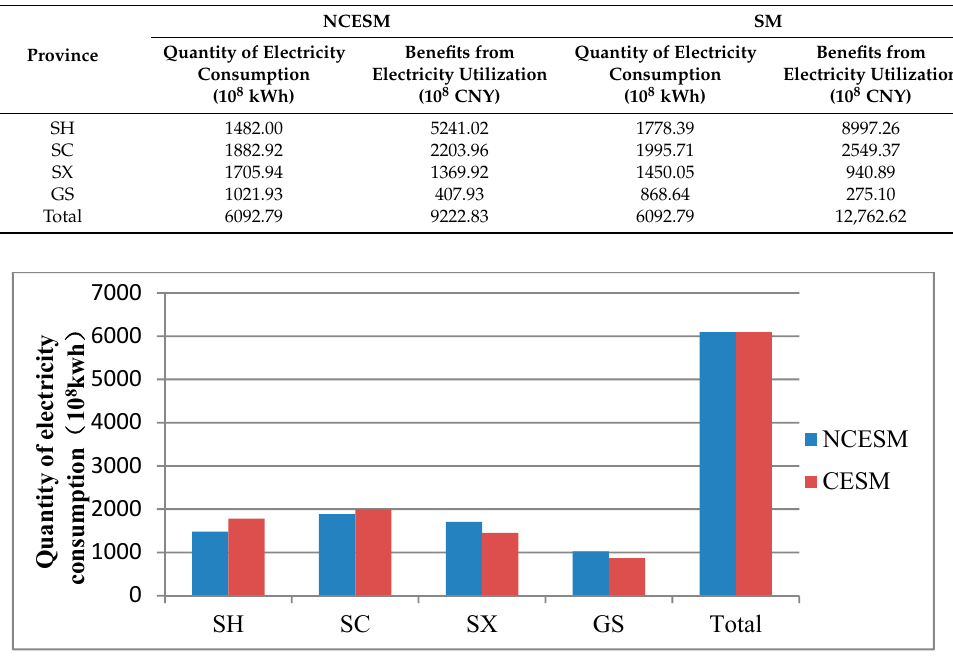
Table 11. Quantity of electricity consumption and benefits from electricity utilization for the CESM and NCESM.